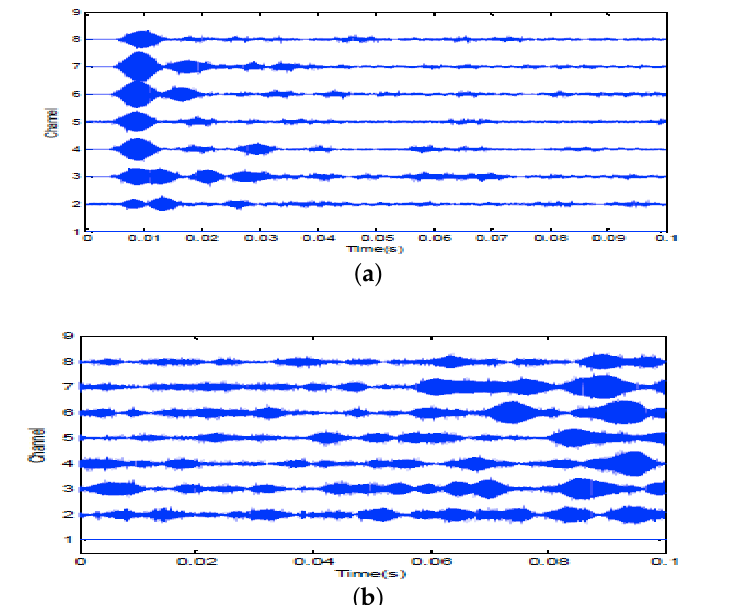
Figure 14. 9 kHz PCW signal: ( a ) echoes received by SRA2 after transmitting a probing signal; ( b ) the time-reversed signal for second